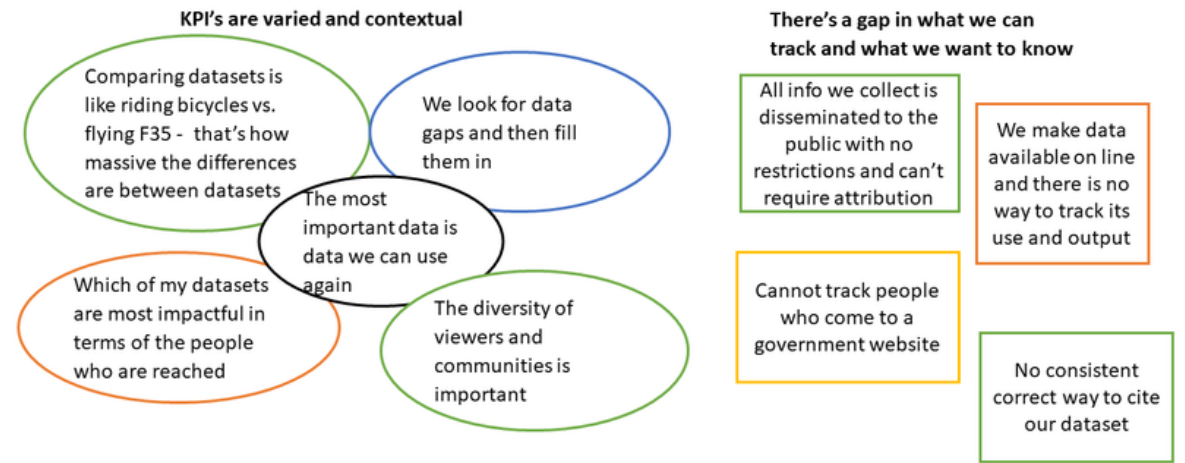
Figure 1. Summary of interviews with